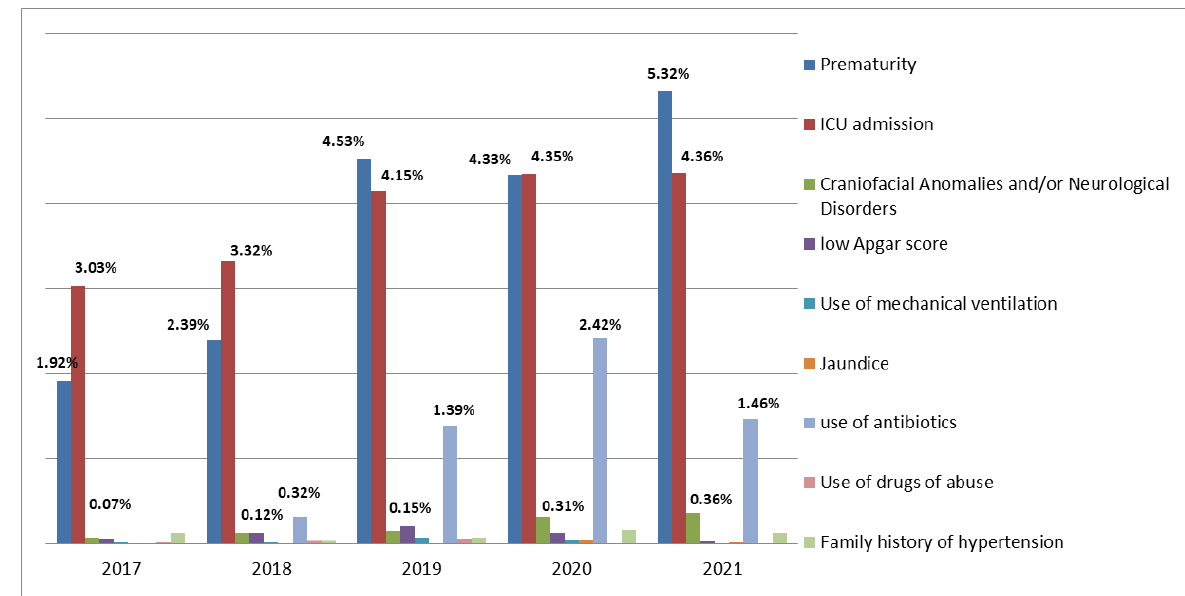
5 Figure 1. Relative frequencies of congenital infections in newborns who underwent UNHS, by year of birth. Florianópolis, SC, 2017 to 2021 (n = 34,801). The RIHL varied between newborns (Figure 2) and year of birth, indicating differ-